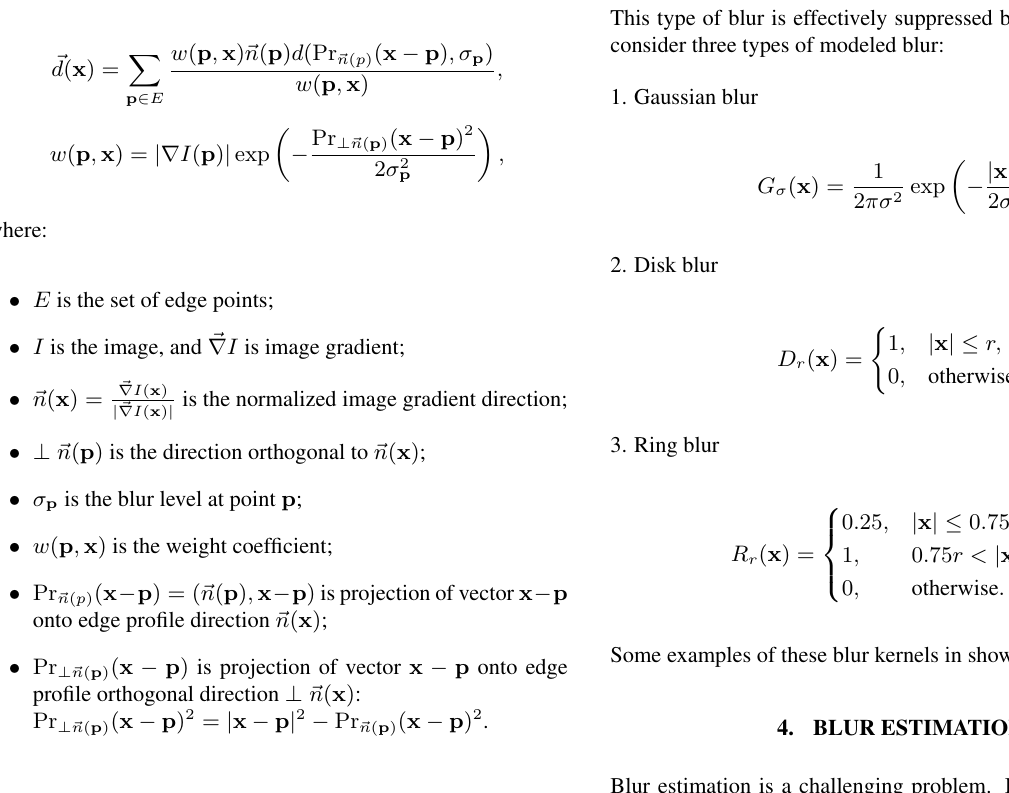
Figure 3. Examples of real out-of-focus blur